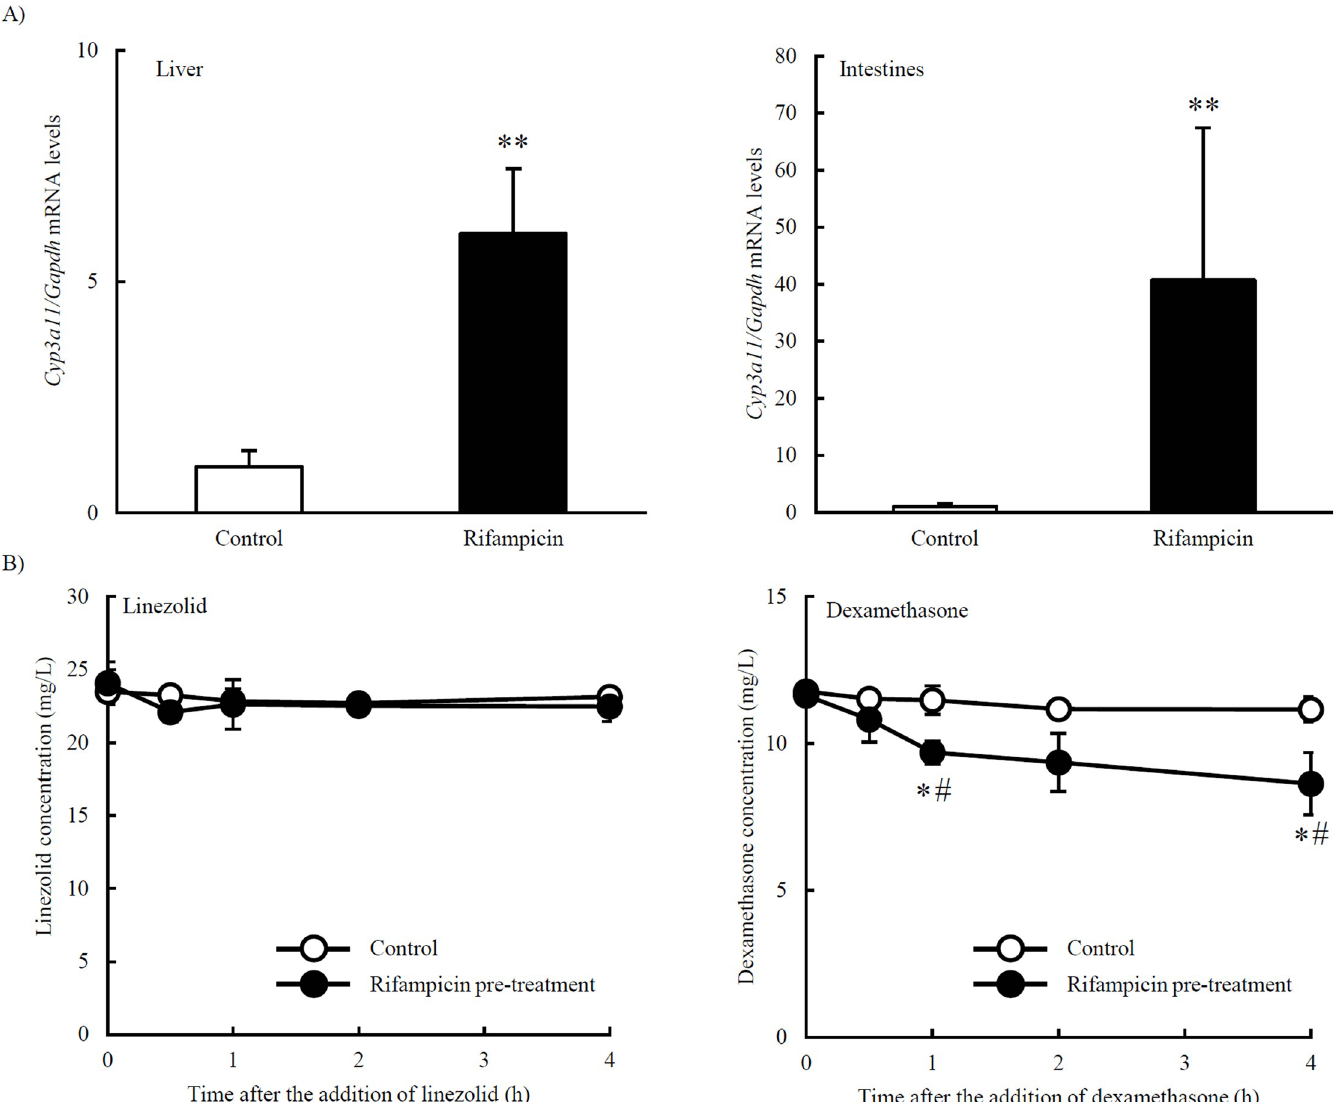
Fig 2. Influence of the induction of CYPs on the pharmacokinetics of linezolid. (A) Effects of the rifampicin pre-treatment on Cyp3a11 expression. Mice were orally administered rifampicin (100 mg/kg) or vehicle (control group) for 7 days. �� P < 0.01 (unpaired t -test). (B) Effects of the rifampicin pre-treatment on linezolid